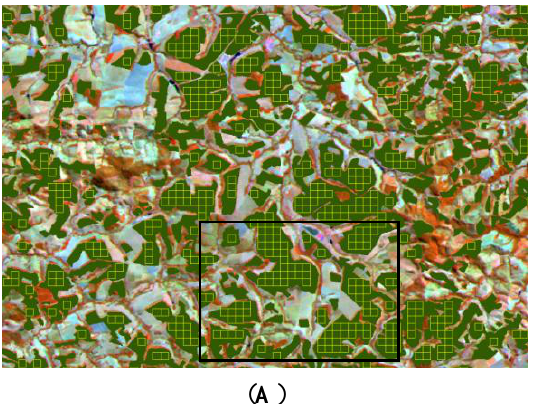
Figure 2. Overlap of the limits of MODIS pixels with coffee fields in TM/Landsat 5 image, false color composite color 3B4R5G, ( A ) pixels fully occupied by coffee crop and ( B ) crop variability within a MODIS pixel in Landsat